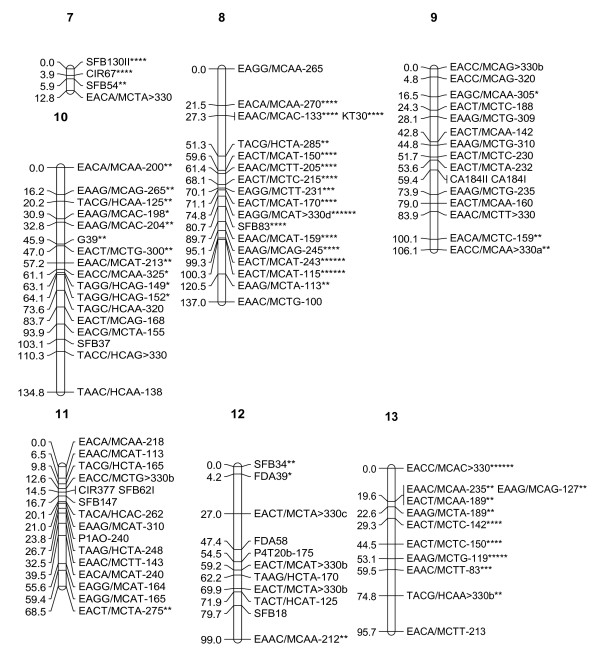
Combined AFLP, SSR and RFLP Map of interspecific hybrid (Palm T128) (Linkage Groups 7–13). Single asterisk: skewed marker at P < 0.1; double asterisk: skewed marker at P < 0.05; three asterisks: skewed marker at P < 0.01; four asterisks: skewed marker at P < 0.005; five asterisks: skewed marker at P < 0.001; six asterisks: skewed marker at P < 0.0005.